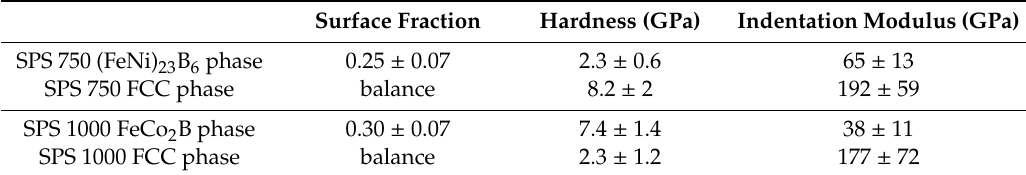
Table 9. Extracted values of indentation modulus and hardness from the statistical study of the 144 dynamic nanoindentation tests at 1